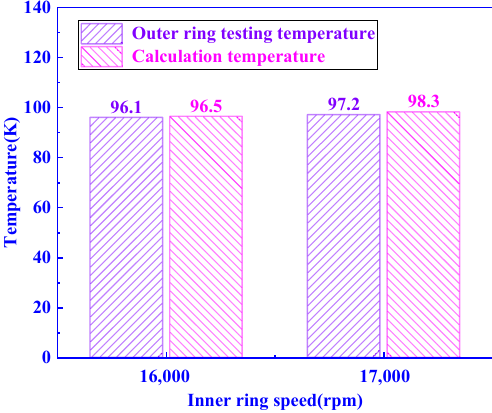
Figure 25. Experimental results for the temperature of the outer ring under 16,000 rpm and 17,000 rpm.